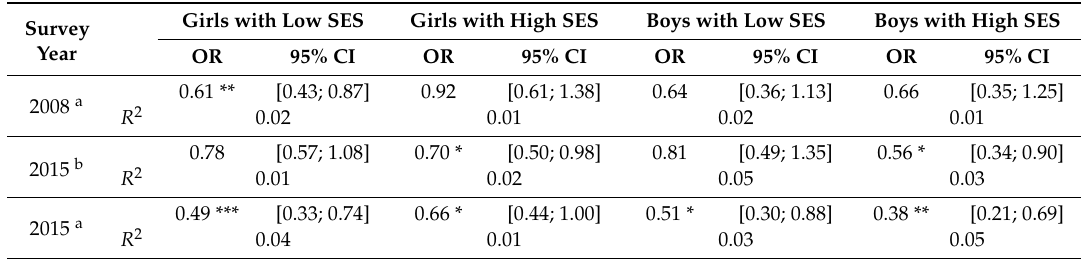
Table 3. Odds ratio (OR) and 95% confidence interval (CI) describing the relationship between sport participation and year by sex and SES, adjusted for age.